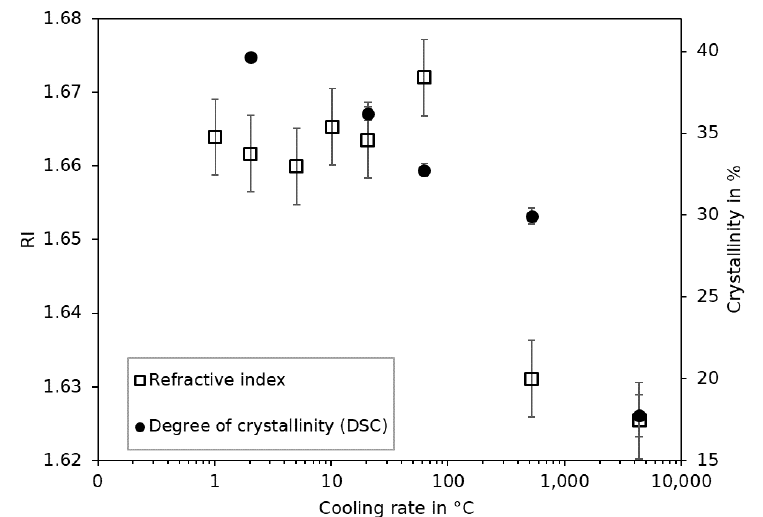
Figure 12. Refractive index (RI) and degree of crystallinity over the cooling rate.